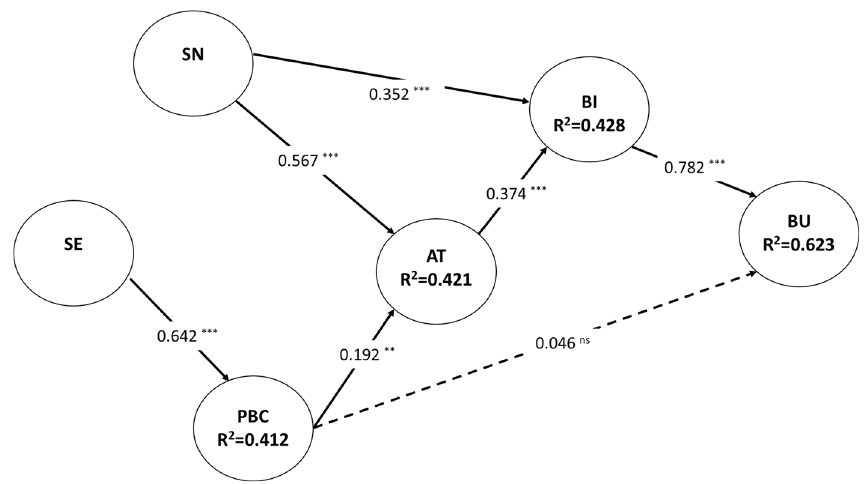
Fig. 2 PLS results for the entire sample